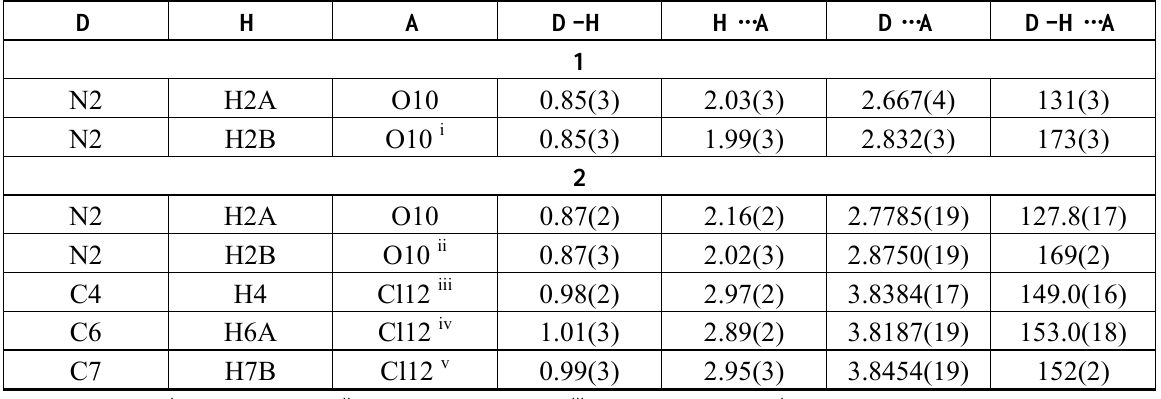
Table 2. Hydrogen bond data (Å, °).